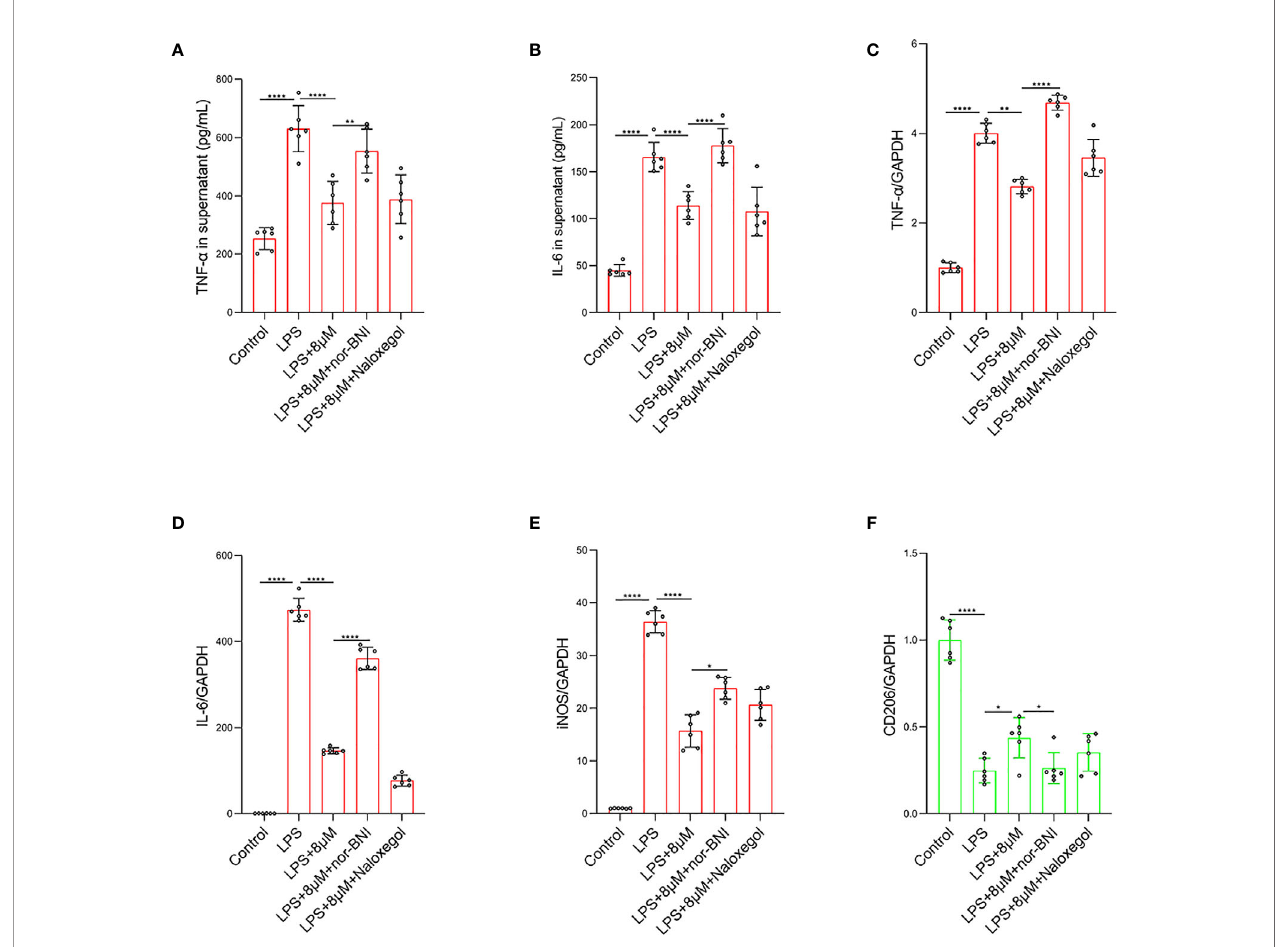
FIGURE 6 | Butorphanol regulated macrophage polarization through the KOR in LPS-induced BMDMs. Macrophages were collected and cultured from the bone marrow of mice and incubated with LPS (1 m g·mL -1 ) alone or butorphanol (8 m M) plus LPS (1 m g·mL -1 ), nor-BNI (KOR antagonist, 5 m M) plus butorphanol (8 m M) plus LPS (1 m g·mL -1 ), or naloxegol (MOR antagonist, 5 m M) plus butorphanol (8 m M) plus LPS (1 m g·mL -1 ) for 24 h. Cells were pretreated with nor-BNI or naloxegol for 30 min. (A, B) TNF- a and IL-6 protein levels in the supernatant of macrophage cultures were determined by ELISA. (C – F) The mRNA levels of TNF- a , IL-6, iNOS and CD206 in cells were measured by qRT-PCR. The results are the means ± SEM of six independent experiments. Statistical analysis was performed by one-way ANOVA followed by Tukey ’ s post hoc test when comparing multiple independent groups. *P < 0.05, **P < 0.01, ****P <